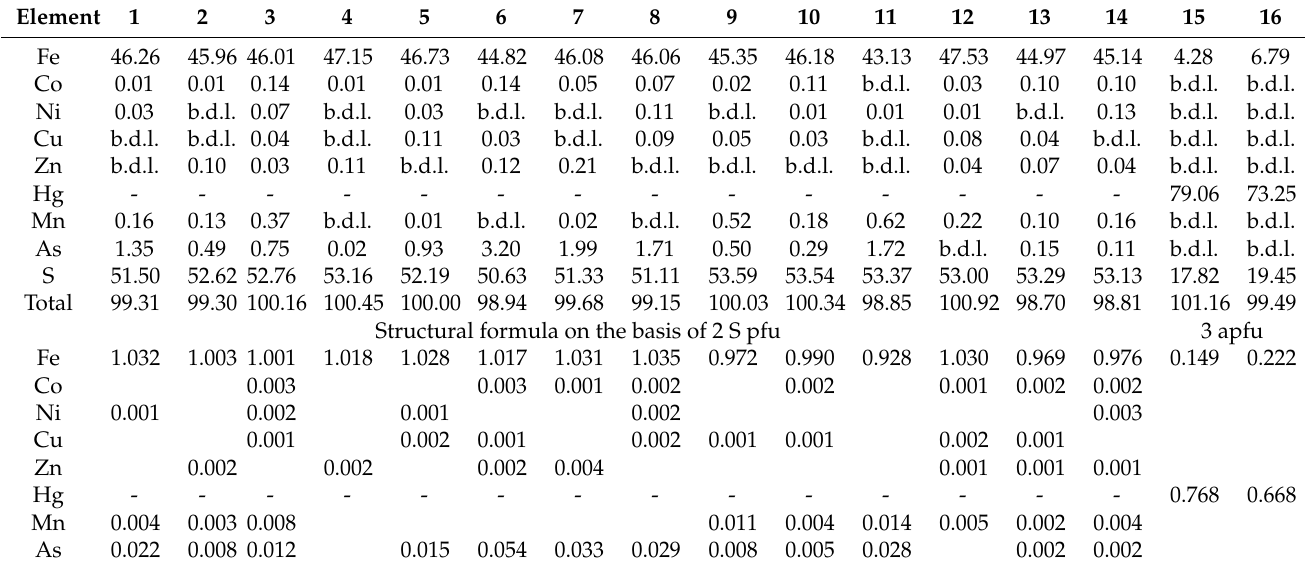
Table 3. Representative electron microprobe analyses of pyrite (1–14) and cinnabar (15–16) from Paleochori. Concentrations in wt %. For the full dataset please refer to supplementary Table S1.